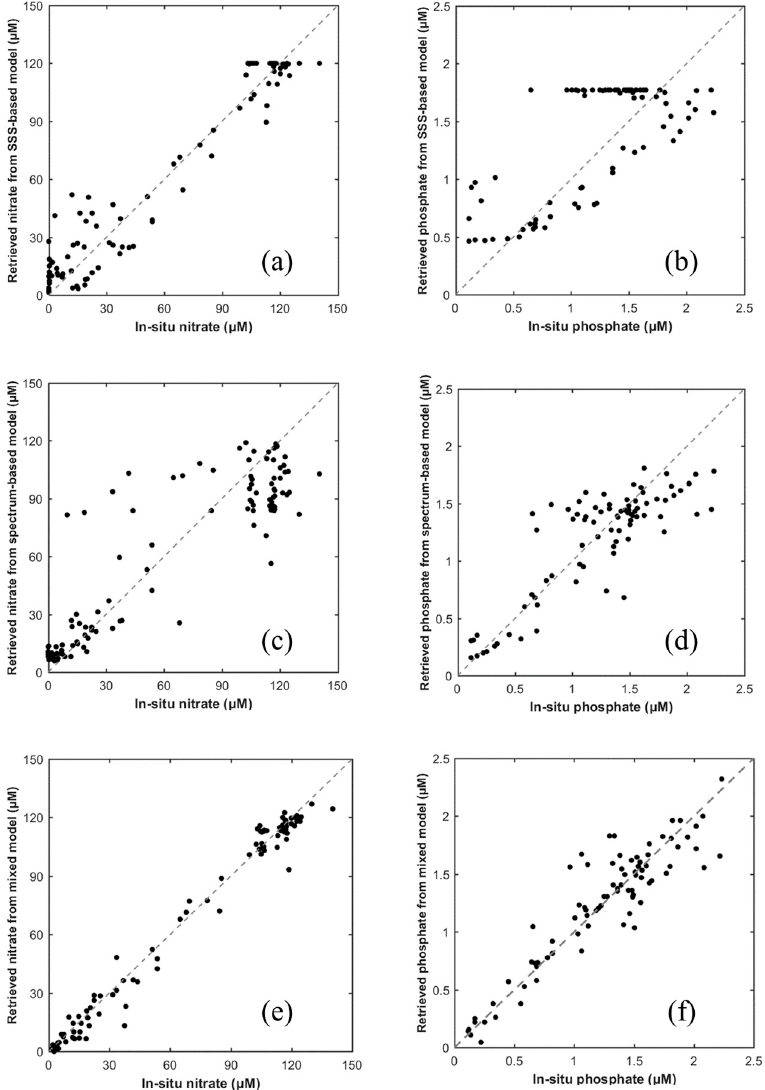
Figure 10. Comparisons between different nutrient models using ( a , b ) sea surface salinity (SSS) as the input parameter (SSS-based model), ( c , d ) remote-sensing reflectance ( R rs ) as the input parameter (spectrum-based model), and ( e , f ) combined SSS and R rs as input parameters (mixed model).